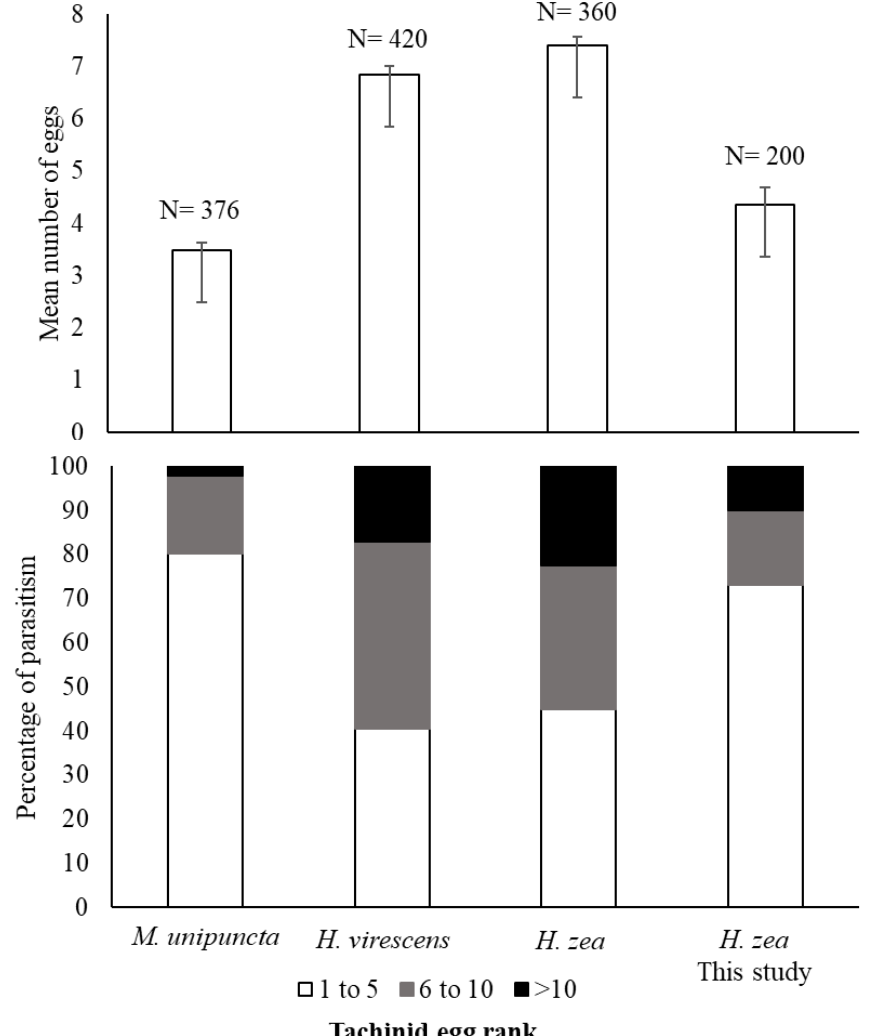
Figure 9. Parasitism of W. rufopicta across different host species. Mean number of eggs per host (upper chart) and percentage of parasitism (bottom). N = the number of caterpillars in each experiment. Whiskers indicate the SE of the mean. Data from M. unipunctata were obtained from Sherman [38], and those on H. virescens and H. zea were summarized from Danks [17].